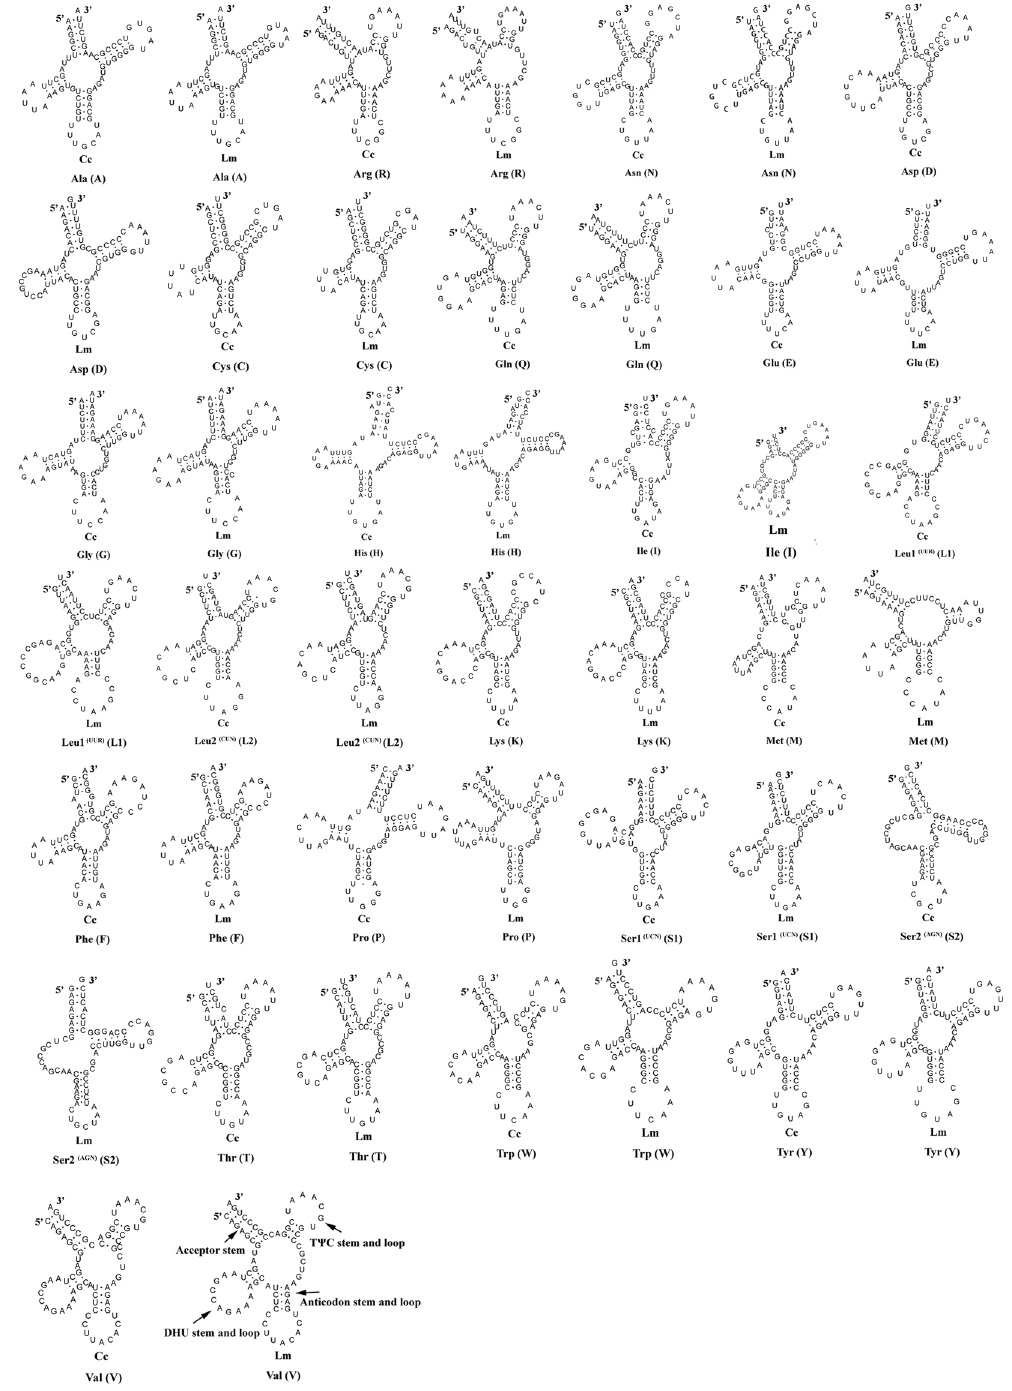
Figure 4. Predicted secondary structures for the tRNA genes in the C. kumu and L. microptera